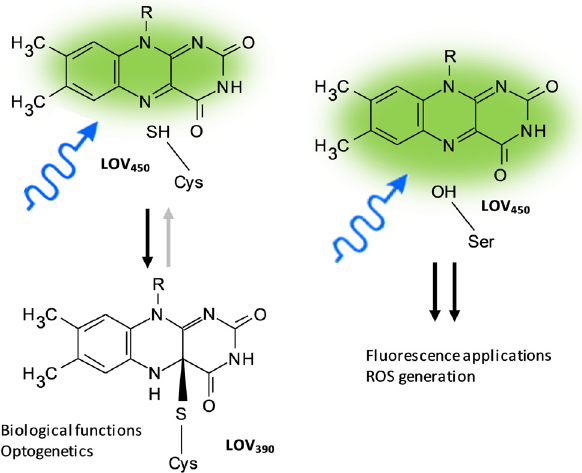
Figure 1: Left, simpli fi ed photocycle of a wt LOV protein. The dark - adapted state LOV 450 is fl uorescent with ca. 20% quantum e ffi - ciency. After BL illumination, the photoproduct LOV 390 is formed with ca. 30 – 50% e ffi ciency via the 2 – 4 ms decay of the FMN triplet state, fl uorescence is lost and biological functions is activated, a feature also exploited in light control of cell functions ( optoge - netics ) . Right, when the reactive Cys is modi fi ed ( here the example of serine ) the photoproduct is not formed, fl uorescence e ffi ciency is higher ( 30 – 50% ) and the triplet lifetime becomes longer: these features are suitable for fl uorescence microscopy and photo - dynamic activity with generation of ROS [ 1 ]